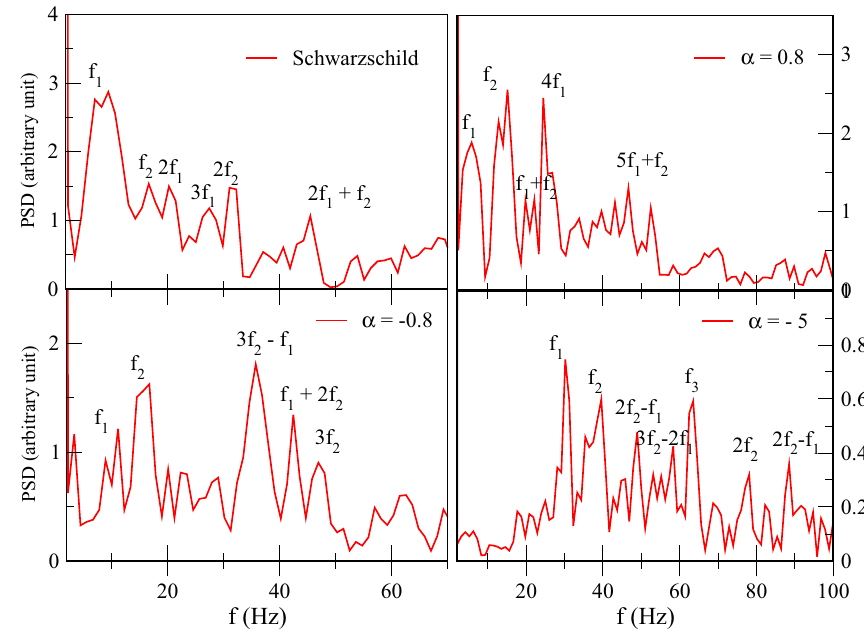
Fig. 8 Power spectra of the mass accretion rate for different values of Gauss–Bonnet coupling constant α and Schwarzschild solution computed at r = 6 . 1 M . The mass of the black hole was assumed to be M = 10 M